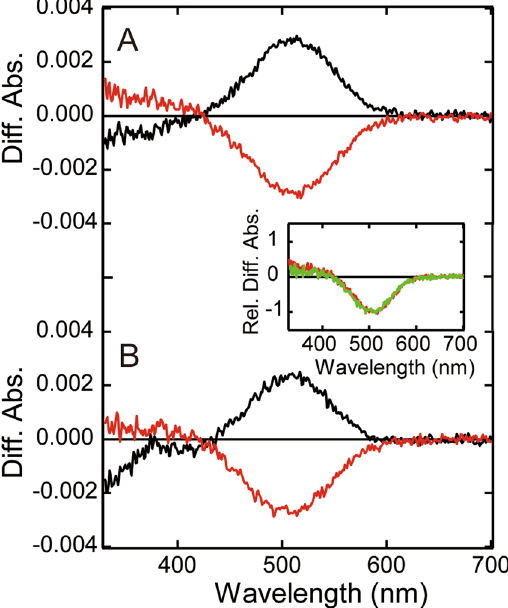
Figure 1. Photoreactions of DM-solubilized Drosophila Rh7. Difference spectra of DM-solubilized Rh7 regenerated with 11- cis -retinal ( A ) and 11- cis -3-hydroxyretinal ( B ) are shown. The black curve was calculated by subtracting the spectrum before irradiation from that after UV light irradiation. The red curve was calculated by subtracting the spectrum after UV light irradiation from that after subsequent yellow light ( > 500 nm) irradiation. Inset shows the superposition of difference spectra shown by red curves in ( A ) and ( B ). Spectra of samples regenerated with 11- cis -retinal (red curve) and 11- cis -3-hydroxyretinal (green curve) were normalized to be ~1.0 at the negative